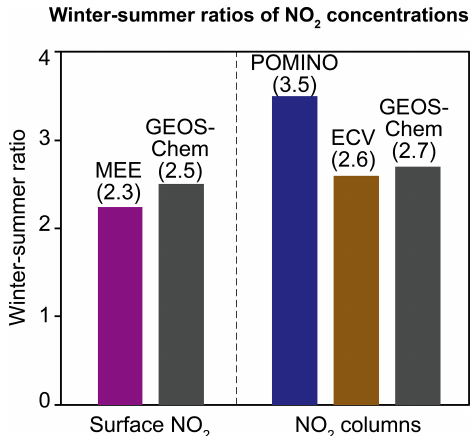
Figure 2. Mean winter–summer ratios of NO 2 concentrations over central–eastern China. The values are ratios of the seasonal mean NO 2 surface concentrations observed at the ensemble of MEE sites in central–eastern China and of the mean POMINO and ECV tro- pospheric NO 2 columns (recalculated using the GEOS-Chem NO 2 profiles) at the MEE station locations. Central–eastern China is as defined by the rectangle in Fig. 1. GEOS-Chem values sampled at the measurement locations are also shown. Observations and model results are for JJA 2017 (summer) and DJF 2016/17 (winter).